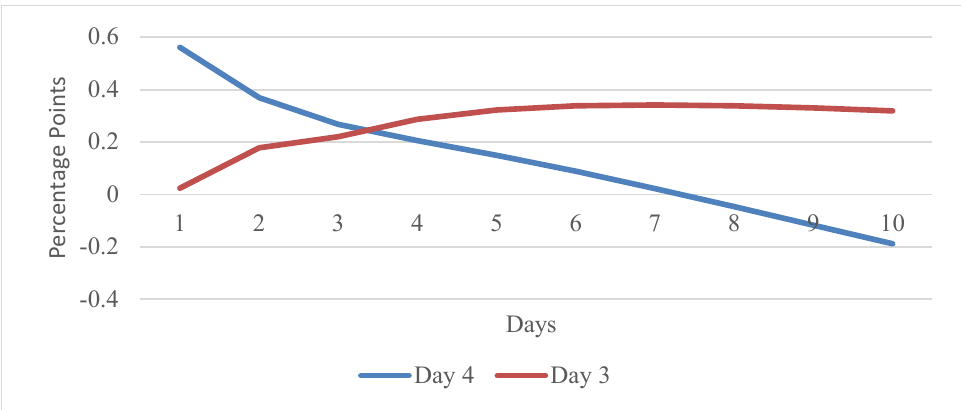
Fig. 8. Responses of unemployment rate to shocks at the middle of the week.